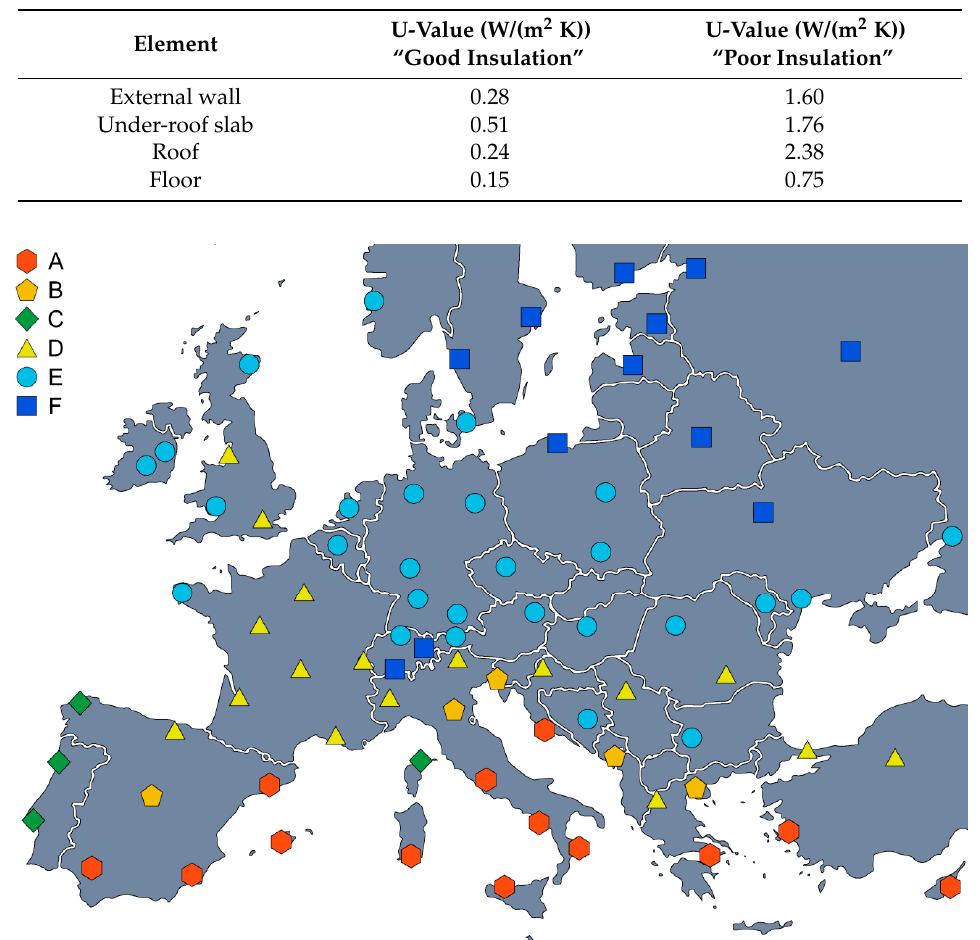
Table 1. Buildings features. (S/V ratio = external Surface area to gross Volume ratio).